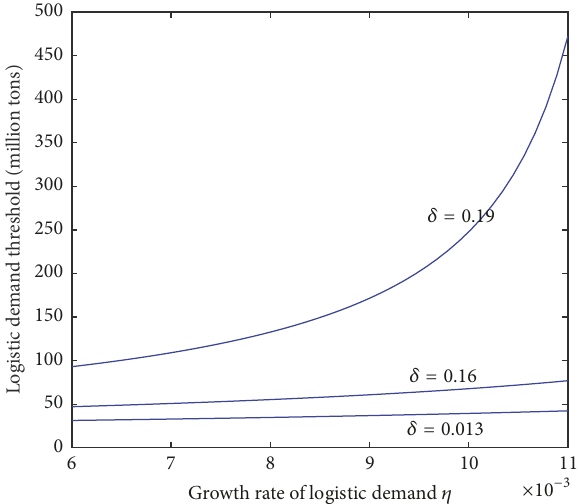
Figure 2: Change of the logistic demand threshold with the growth rate of logistic demand and volatility.